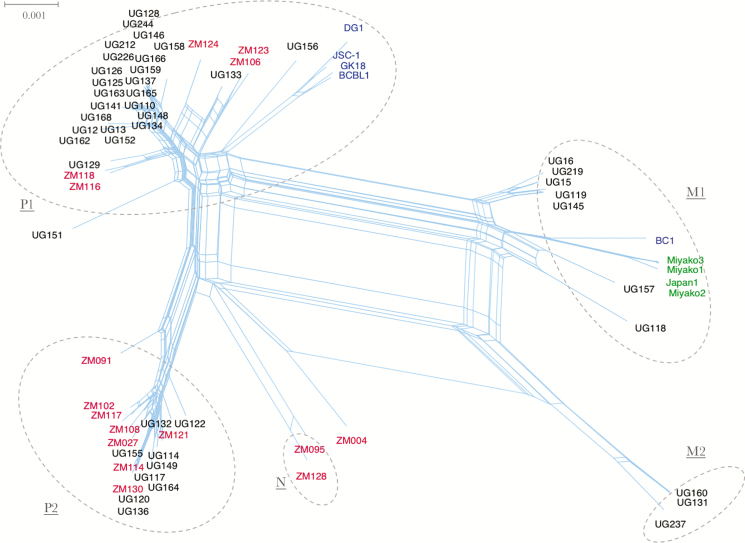
Neighbor-net phylogenetic network based on complete genomes of all 70 Kaposi sarcoma-associated herpesvirus samples. Parallel edges depict conflicting phylogenetic signals. The samples clustered into 5 distinct types (dotted circles) designated types P1, P2, M1, M2, and N, and 1 outlier ZM004, which did not cluster well with any type and thus may be a putative intertype recombinant or a novel type. The tips are labeled to represent sample geographic origin: black (Uganda), red, (Zambia), blue (Western), and green (Japan).